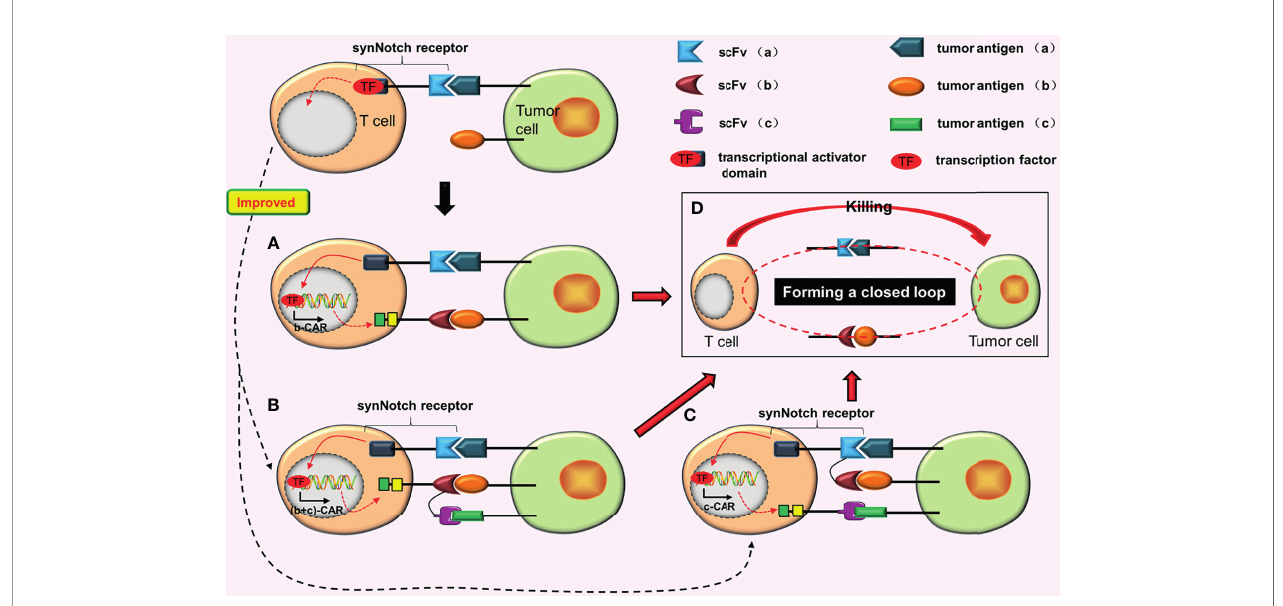
FIGURE 3 | AND gate CARs. (A) When the synNotch receptor binds to tumor antigen (a), the transcriptional activator domain of the receptor is released, which can enter the nucleus and drive the expression of b-CAR genes. Subsequently, b-CAR will be expressed on the surface of the T cell, and the newly expressed b-CAR speci fi cally binds to tumor antigen (b) to form a closed loop. The CAR-T cell is fi nally activated. (B) The synNotch receptor binds to tumor antigen (a) and induces TanCAR (b + c) expression. At this point, as long as one or two scFvs of this TanCAR bind to the corresponding tumor antigens, the T cell will be activated. (C) Adding a TanCAR to the synNotch receptor. As long as one of the scFv or two scFvs of this TanCAR bind to the corresponding tumor antigens, the expression of c-CAR will be induced. (D) Once the closed loop is formed, CAR-T cells will be